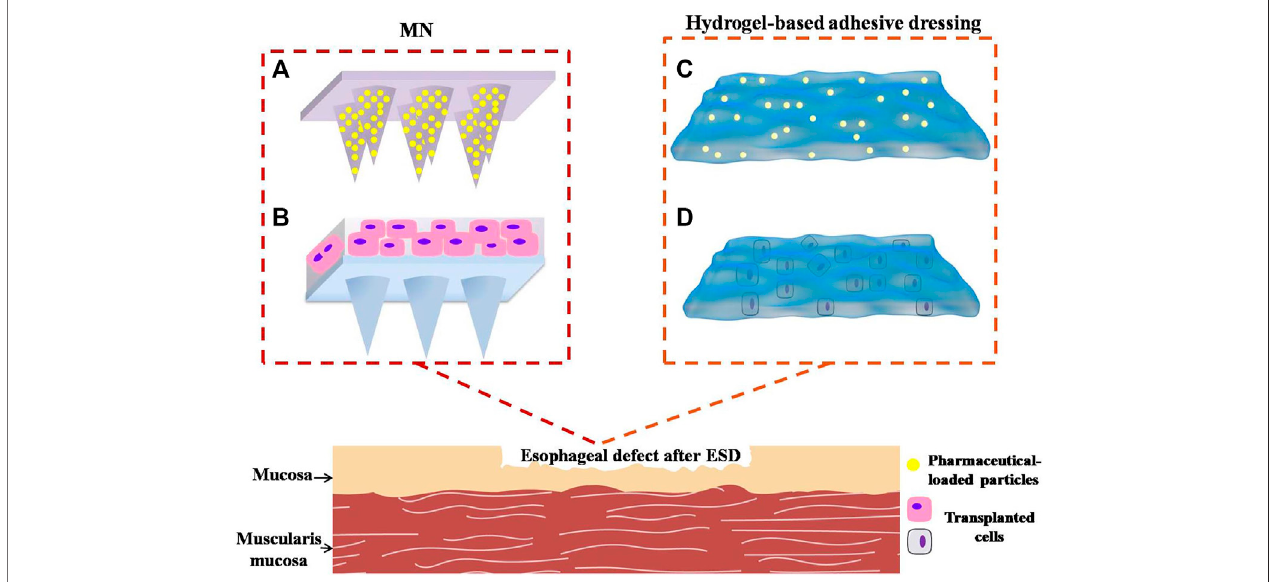
FIGURE 10 | Novel potential strategies involve polymeric materials to prevent post-ESD esophageal stricture. (A) Microneedles loading anti-in fl ammatory or anti- fi brosis drugsintotheneedlebody. (B) Microneedles incorporating activefunctionalcells. (C) Hydrogel-based adhesive dressingloadingpharmaceuticals. (D) Hydrogel adhesives incorporating transplanted